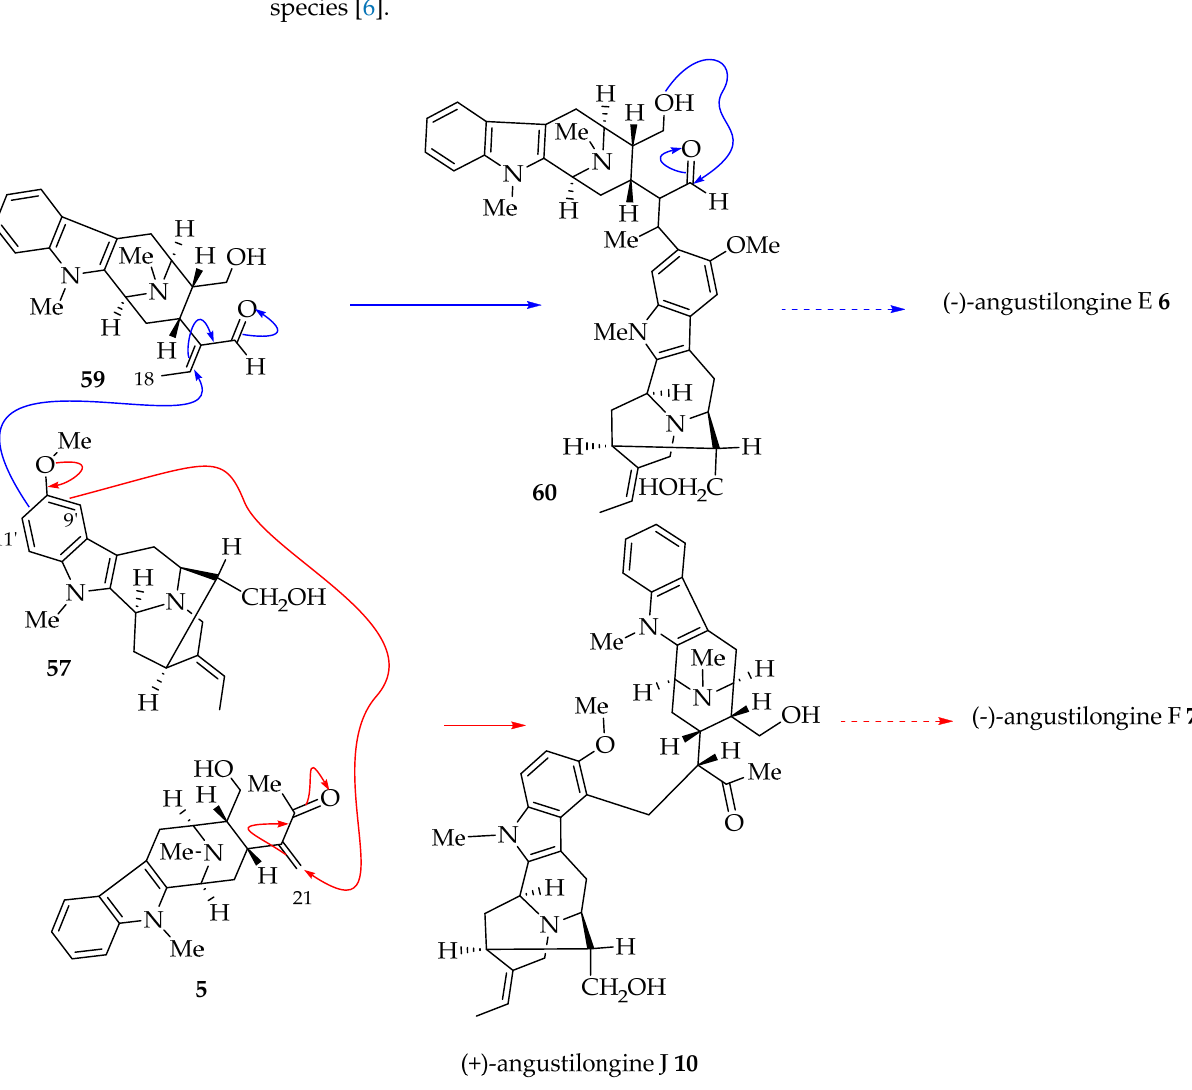
Figure 2. Proposed biogenetic pathway to ( − )-angustilongine E 6 , ( − )-angustilongine F 7 , and (+)-angustilongine J 10 .